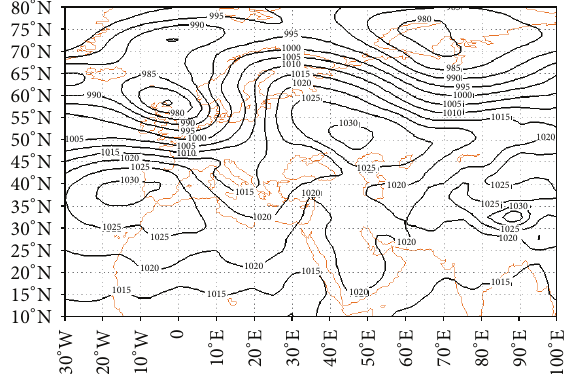
Figure 13: Sea level pressure map.